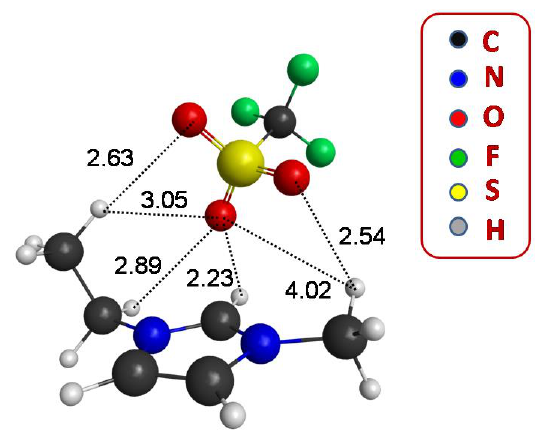
Figure 5. Lowest energy configuration of the EMI–TfO ionic couple, obtained by DFT calculations employing the ωB97X-D functional (including empirical dispersion corrections) and the 6-31G** basis set. The numbers are the distances of selected atoms, expressed in Å .